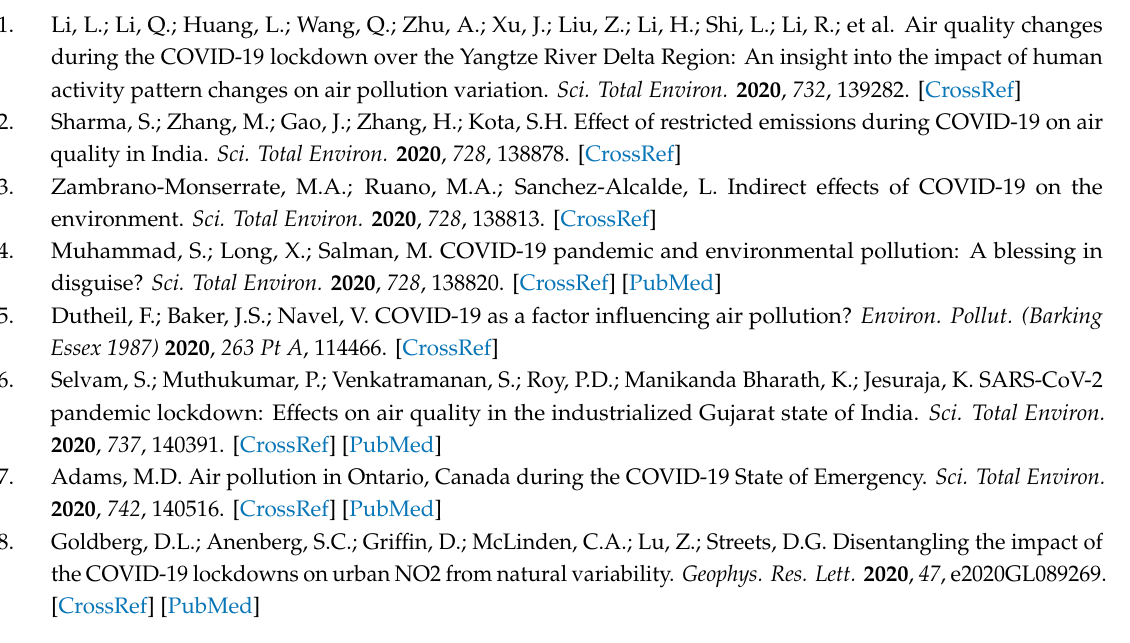
represented in natural logarithmic values for individual counties.